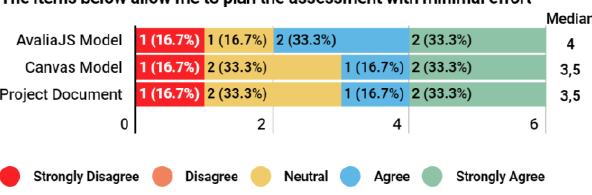
Figure 11. Experts’ answers regarding the efficiency (item 9) of the AvaliaJS model.